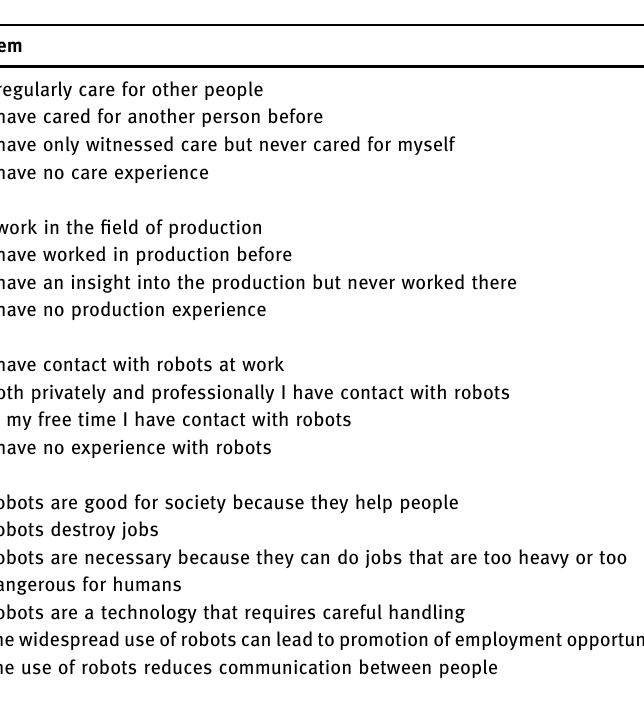
Table 1: Items used in the